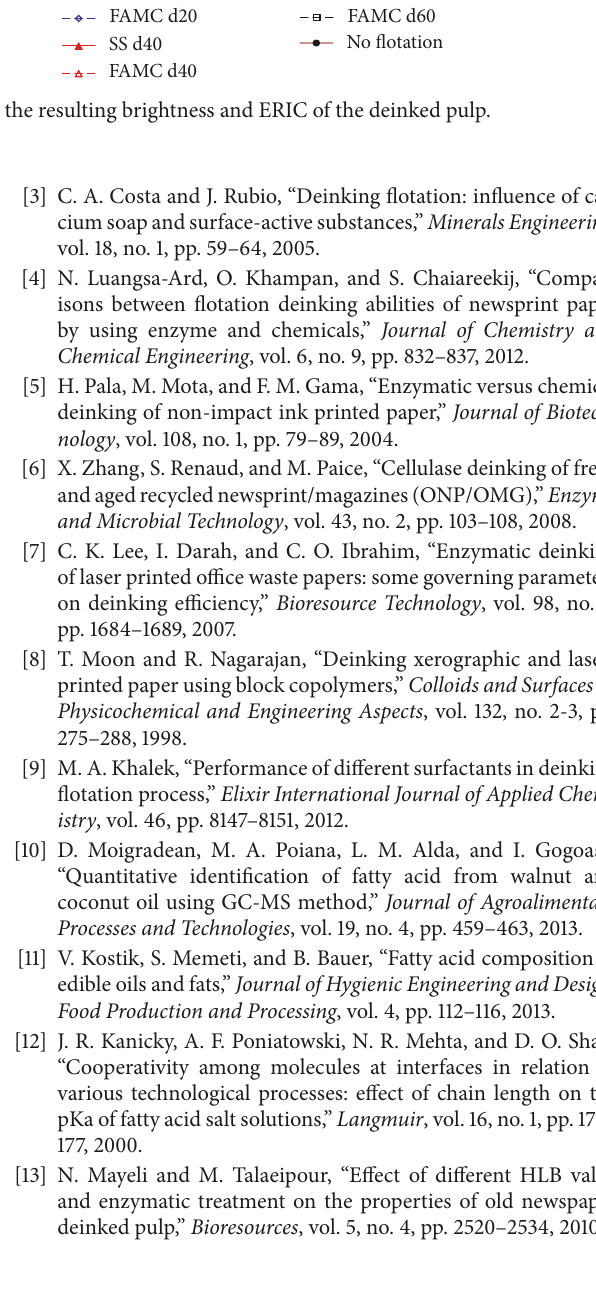
Viscous forces in flotation zone (mg/mm s 2 )